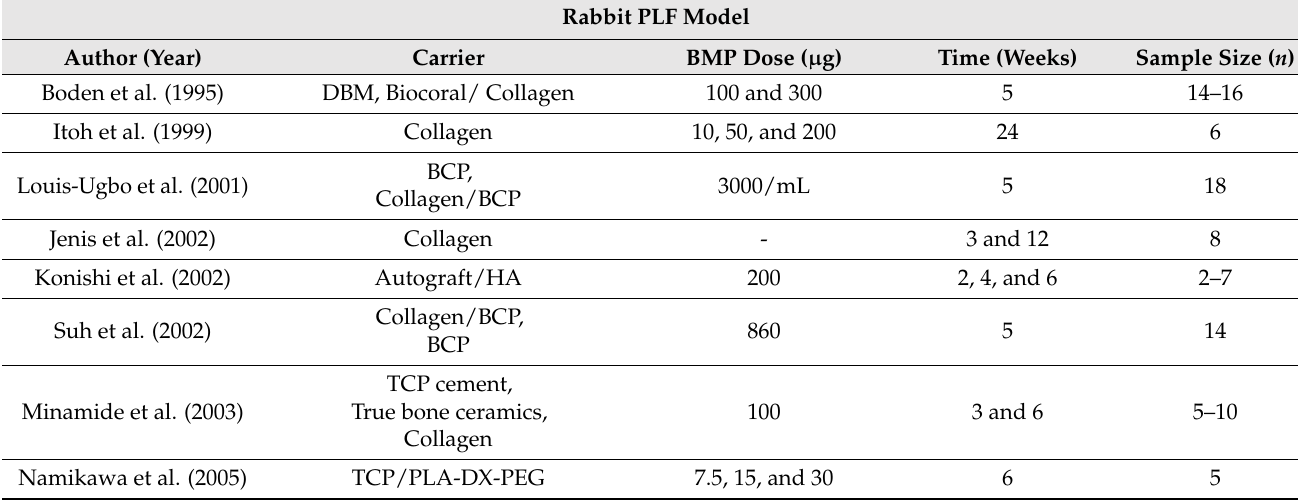
Table 4. Rabbit PLF